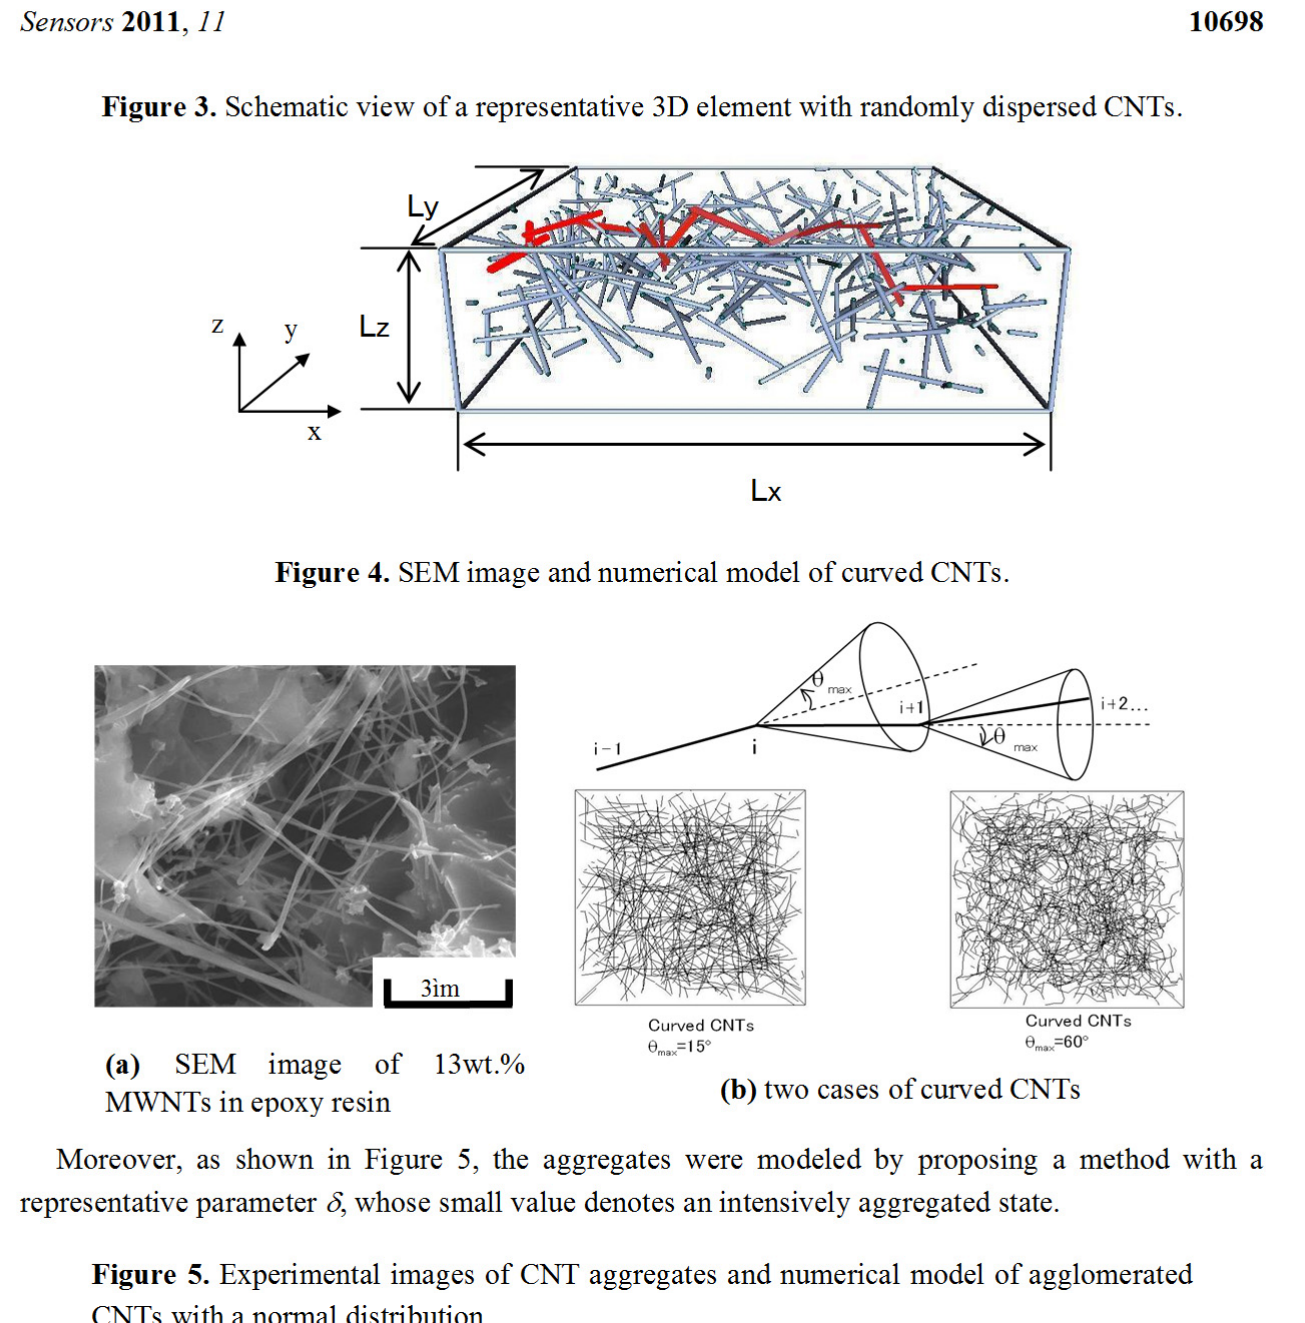
Figure 5. Experimental images of CNT aggregates and numerical model of agglomerated CNTs with a normal